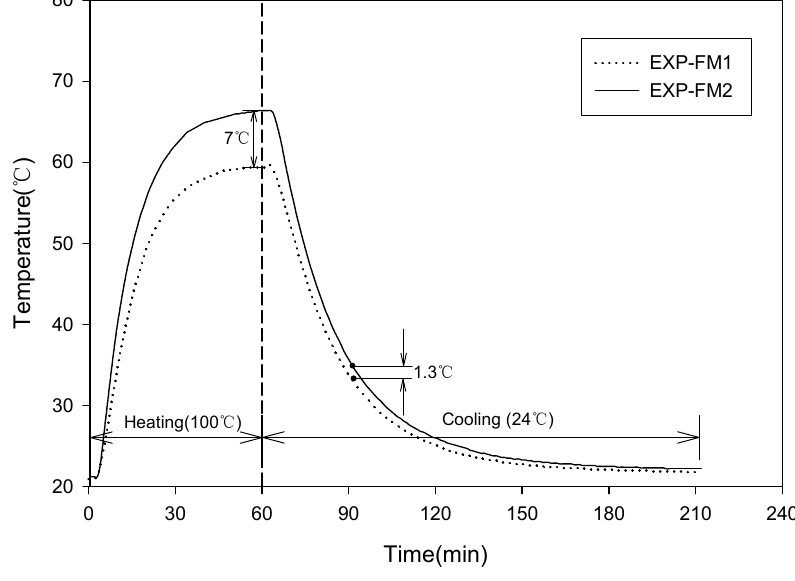
Figure 11. Result of heat storage (heating for 60 min).